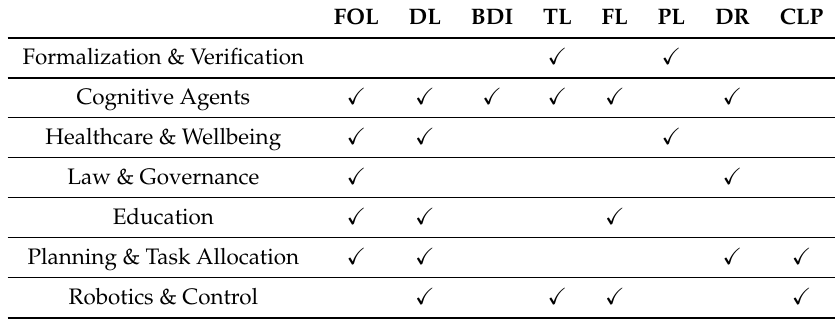
Table 1. Sorts of logic per application area. Acronym and abbreviation key: FOL: First-Order Logic; DL: Description Logic; BDI: Belief–Desire–Intention (Logic); TL: Temporal Logic; FL: Fuzzy Logic; PL: Probabilistic Logic; DR: Defeasible Reasoning; CLP: Constraint Logic